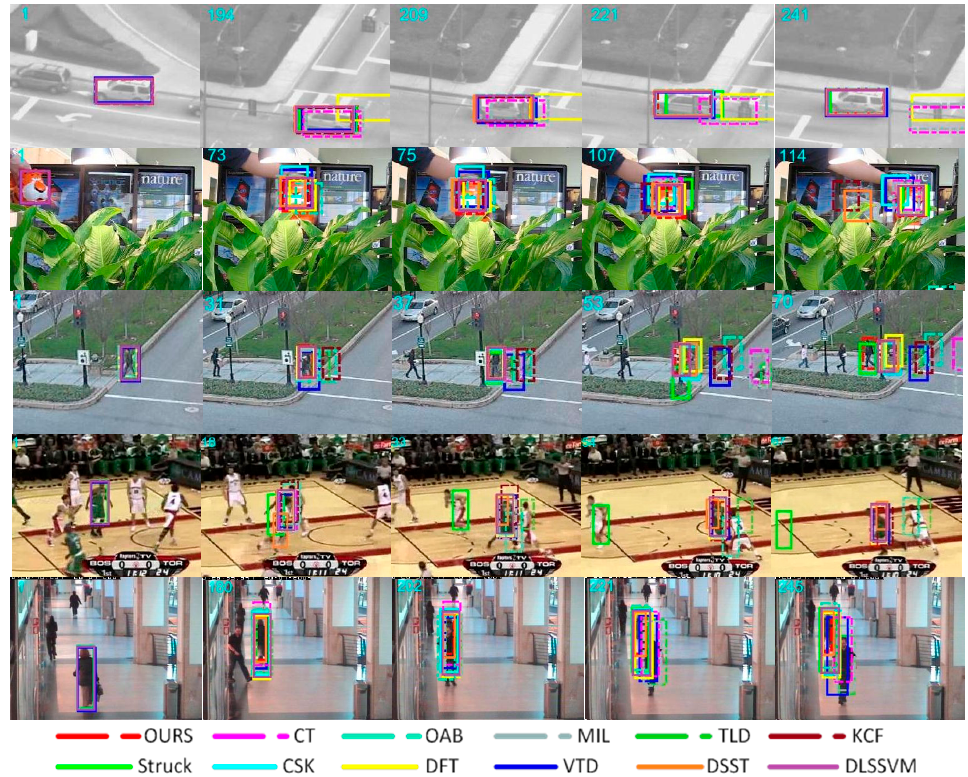
Figure 5. Tracking results of the proposed method and eleven state-of-the-art tracking methods on sequences Suv , Tiger2 , Human3 , Basketball , and Walking2 . In these sequences, the objects undergo occlusion.